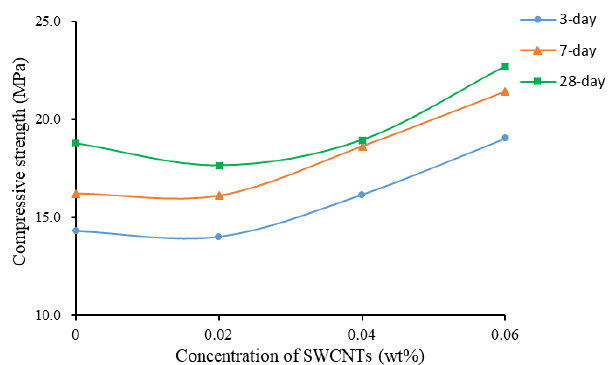
Figure 7. Compressive strength as a function of concentration of SWCNTs.